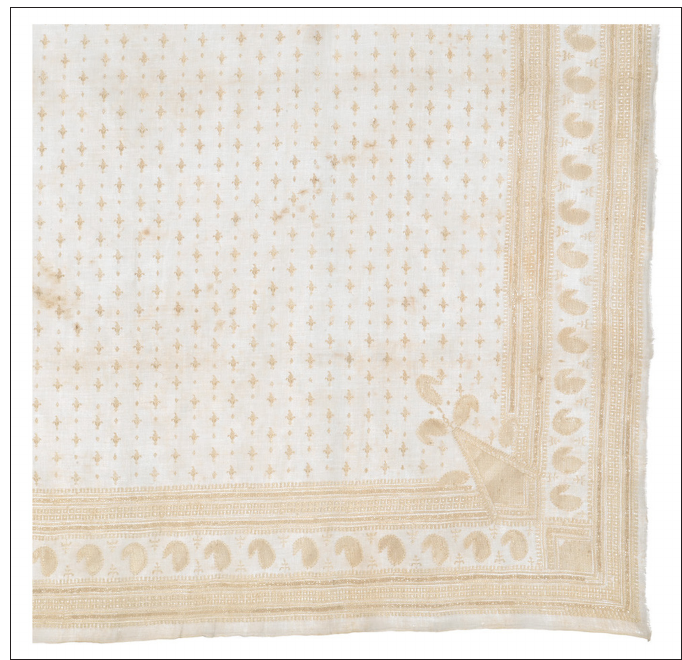
Fig. 11 : Embroidery, silk on muslin, Iran (Kashan), nineteenth century. T14, given by Miss E. G. Tanner in 1927. © Holburne Museum, Bath. Photo: